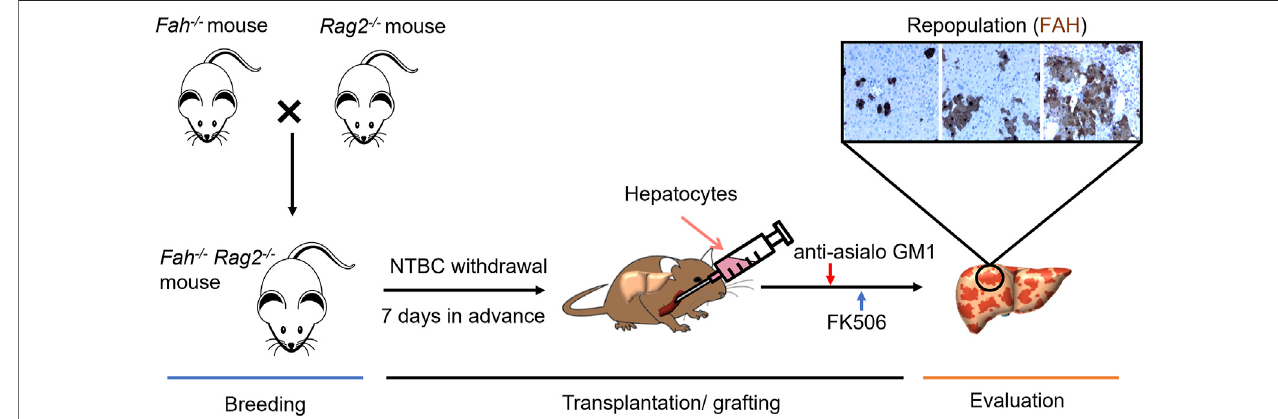
FIGURE 2 | Development of Fah − / − Rag2 − / − Mouse Model and its Application for Functional Evaluation of Hepatocytes. Breeding: Fah − / − Rag2 − / − mouse were generated from the cross breeding of homozygous Fah − / − mouse and Rag2 − / − mouse. The breed is maintained as Fah − / − Rag2 − / − or Fah − / − Rag2 +/ − with daily NTBC water supply. Transplantation/grafting: Liver injury condition developed 1 week before transplantation by withdrawing NTBC with a stepwise protocol, primary hepatocytesorgeneratedfromother sourcescanthenbetransplanted via bloodfusionornowbypatchgrafting.Anti-asialo GM1andFK506 werethen gavedaily for promoting the engraftment of donor hepatocytes. Evaluation: Repopulation rate of donor hepatocytes in Fah − / − Rag2 − / − liver can be con fi rmed by IHC staining of FAH.